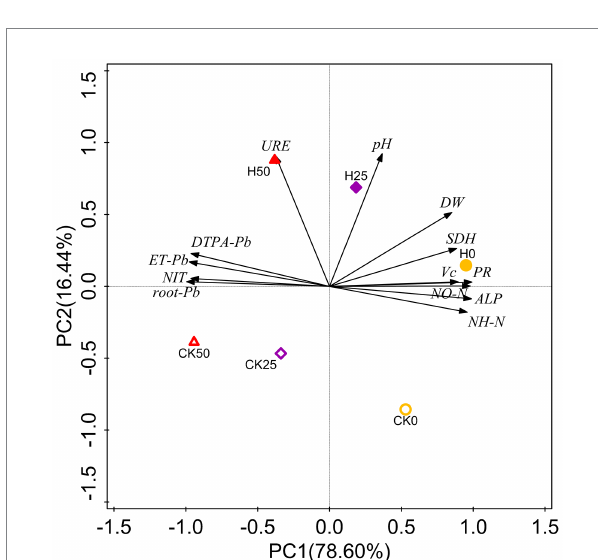
FIGURE 5 PCA of Pb content in soil and pakchoi, biochemical indices of pakchoi, and the chemical properties and enzyme activity in its rhizospheric soils. DTPA-Pb, DTPA-extractable Pb content; root-Pb, Pb content in roots; ET-Pb, Pb content in edible tissues; DW, dry weight; NIT, nitrite content; VC, vitamin C content; PR, soluble protein content; NH-N, ammonia nitrogen (NH 4+ -N) content; NO-N, nitrate-nitrogen (NO 3 − -N) content; URE, urease activity; ALP, alkaline phosphatase activity; SDH, dehydrogenase